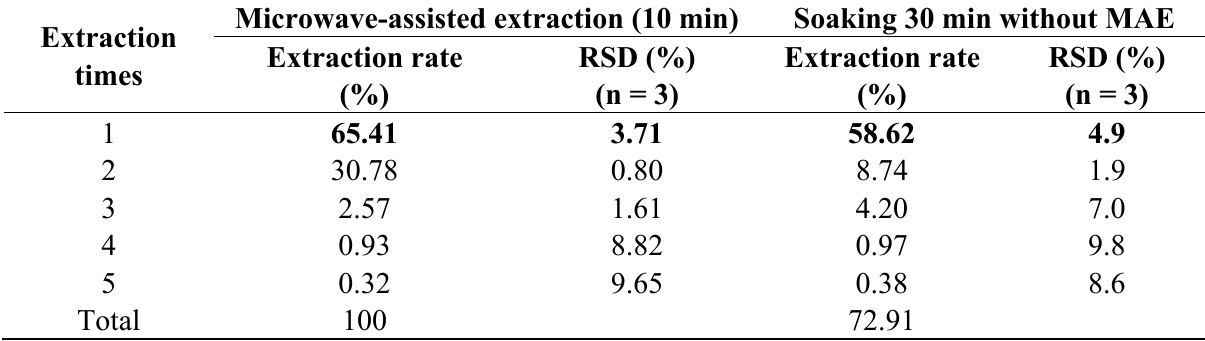
Table 2. Effects of extraction times on extraction rate of